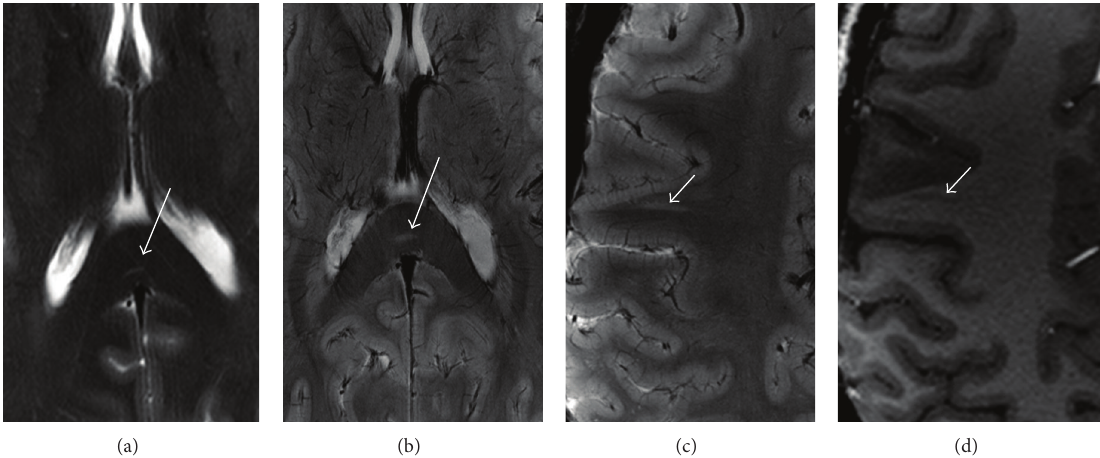
F 2: Examples of “thread-like” lesions in NMOsd. read-like lesions in two patients. A thread-like lesion along the corpus callosum white matter tract instead of venous course in one patient on T2-weighted (a) and T2 lesion in subcortical region on T2 ∗